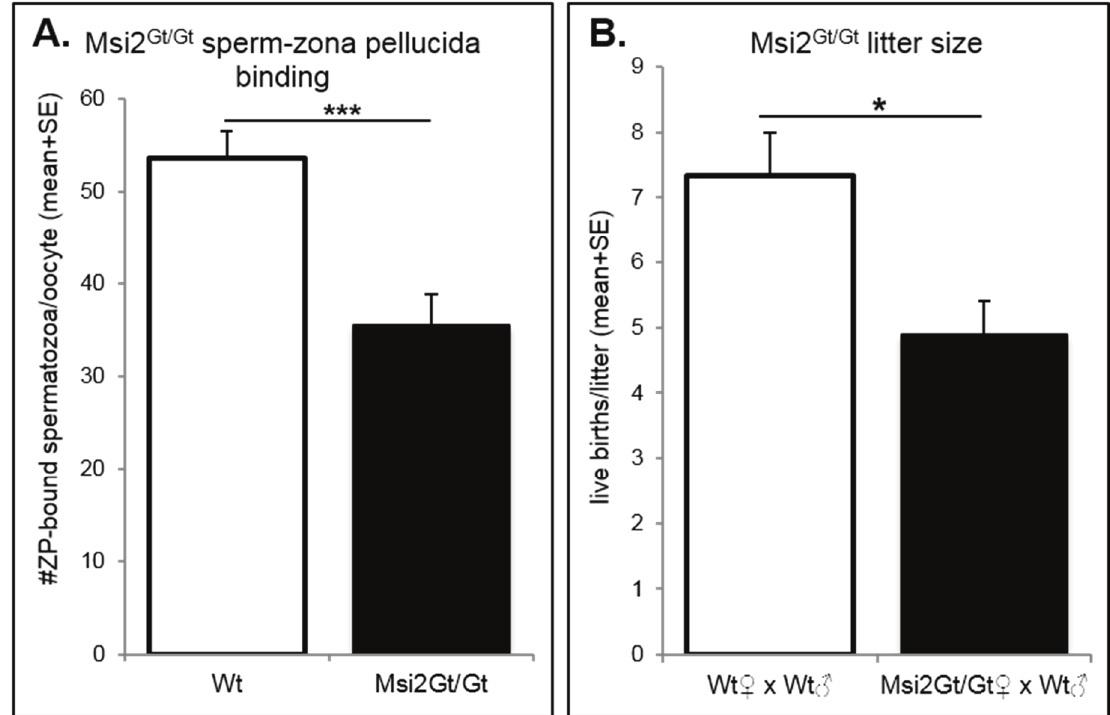
Figure 7. Assessment of Msi2 Gt/Gt fertility. ( A ) Sperm-zona pellucida binding in Msi2 Gt/Gt ( n = 8) and Wt ( n = 9) MII oocytes. MII oocytes were collected from the oviductal ampullae of super-ovulated adult mice and subjected to sperm zona-binding with capacitated mature epididymal spermatozoa from control adult males. Following incubation and washing, the number of sperm that remained bound to the zona pellucida was counted. ***: denotes p < 0.001. ( B ) Average litter size in Msi2 Gt/Gt and Wt females. Breeding pairs were